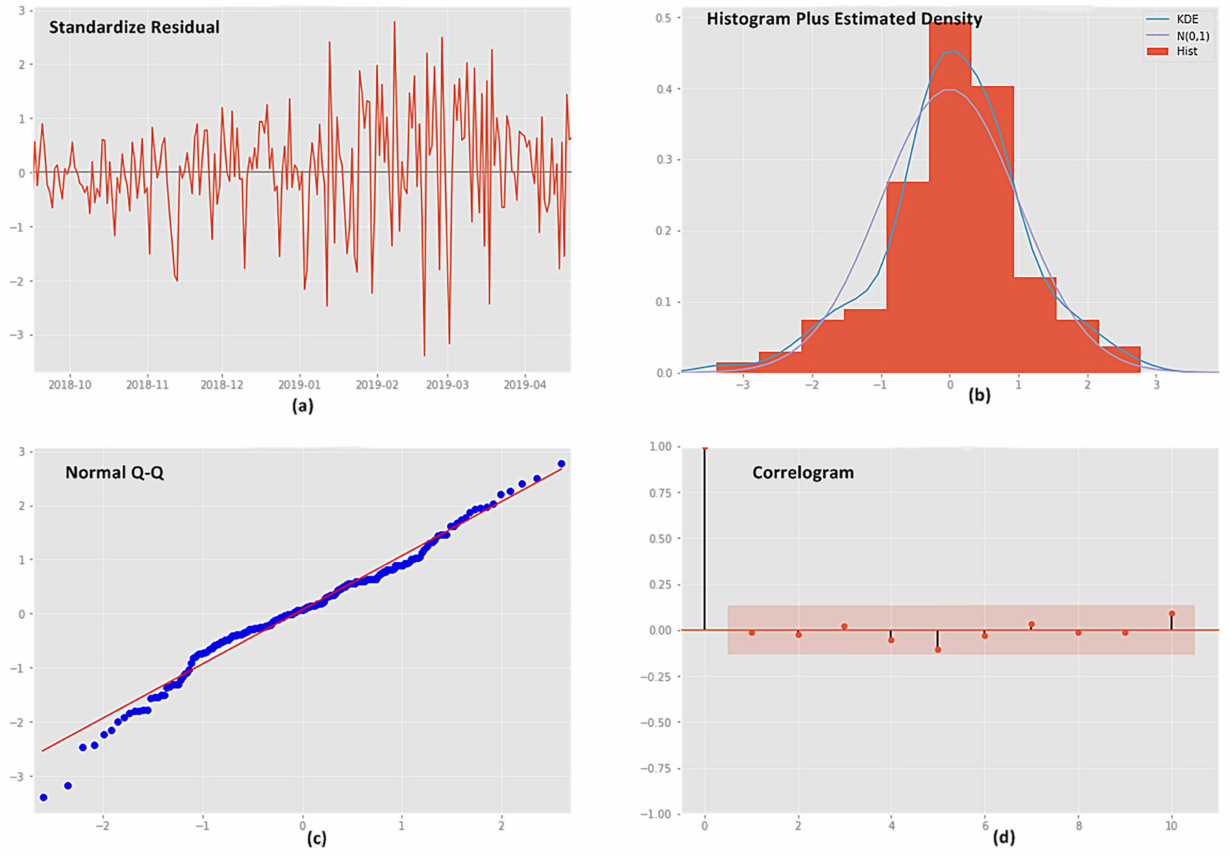
Figure 6. Visualization plotted by using 6 months of data from 1 year of real-time data of PR through the machine learning algorithm. ( a ) Difference between the observed and expected values of PR. ( b ) PR data values into the specified range. ( c ) Distribution for a random variable in the given PR data. ( d ) Illustration of the randomness in the PR